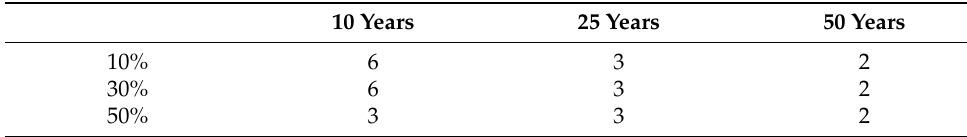
Table 5. Number of thinning per thinning